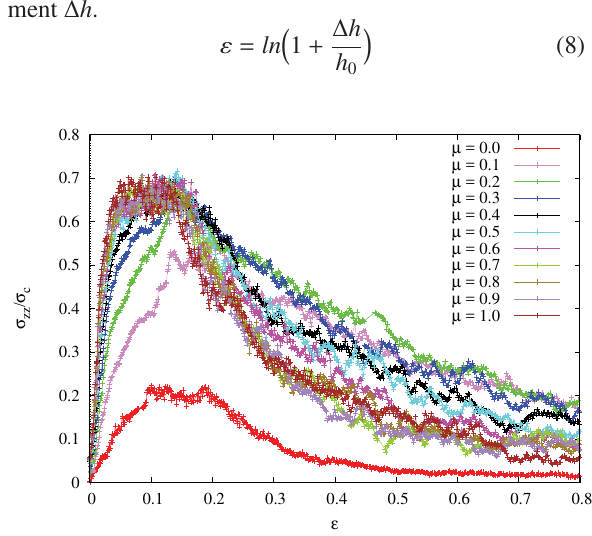
Figure 3. Vertical strength normalized by the reference stress σ ffi cient μ as a function of cumulative c for values of friction coe vertical strain.